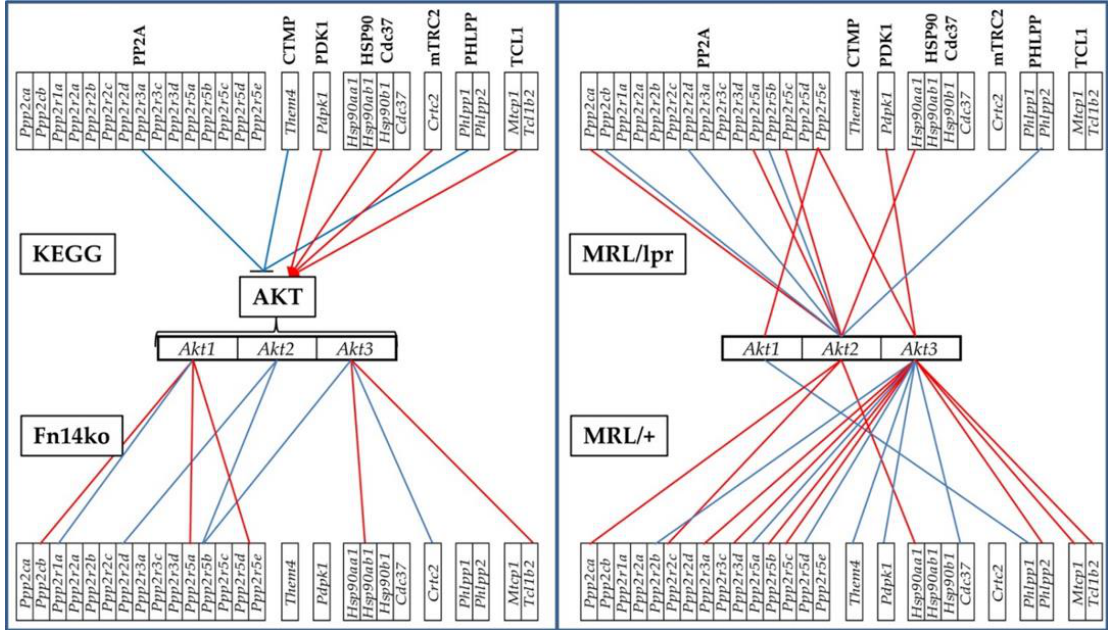
Figure 4. Phenotype-dependent transcriptomic network of AKT genes with their KEGG-derived activator and inhibitor genes in the hippocampus. Red/blue lines depict statistically significant ( p < 0.05) expression synergism/antagonism between the linked genes. Red line indicates synergism, and blue line antagonism between the 2 genes.